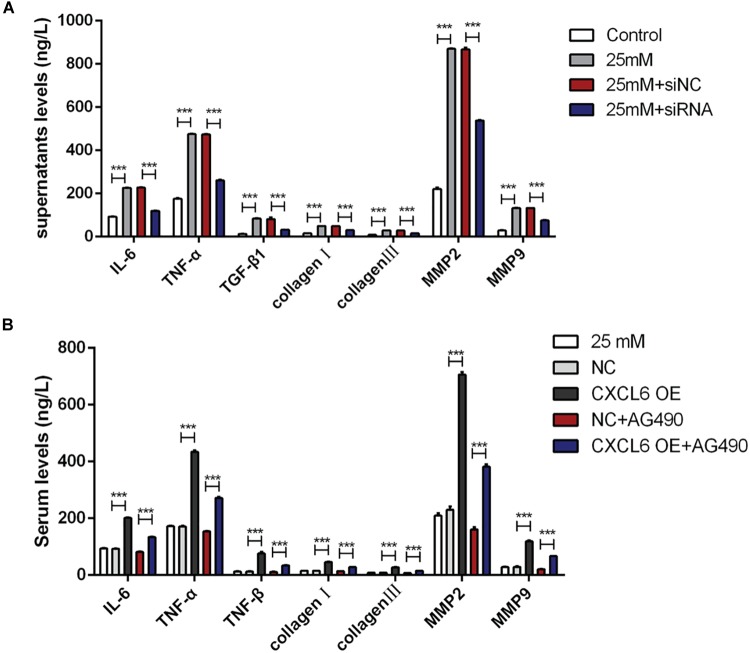
Effects of CXCL6 on fibrosis related factors in high glucose-induced NRK-49F. The levels of IL-6, TGF-α/TGF-β1, Collagen I/III and MMP2/MMP9 in CXCL6 knocked down (A) and CXCL6 overexpressed (B) NRK-49F cell culture supernatants were determined by Elisa assay. ∗∗∗P < 0.001.